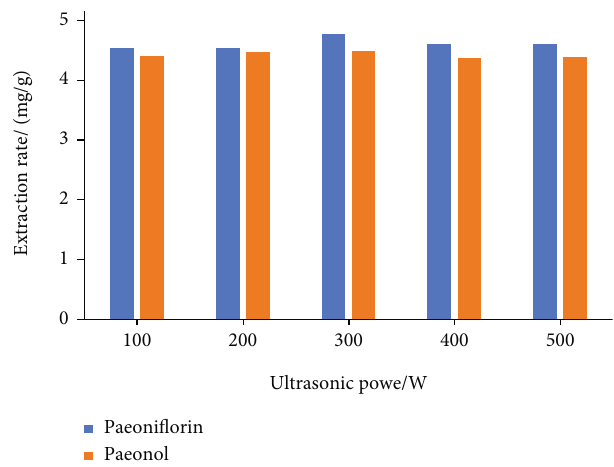
Figure 5: E ff ect of ultrasonic power on Moutan Cortex extraction e ffi ciency.